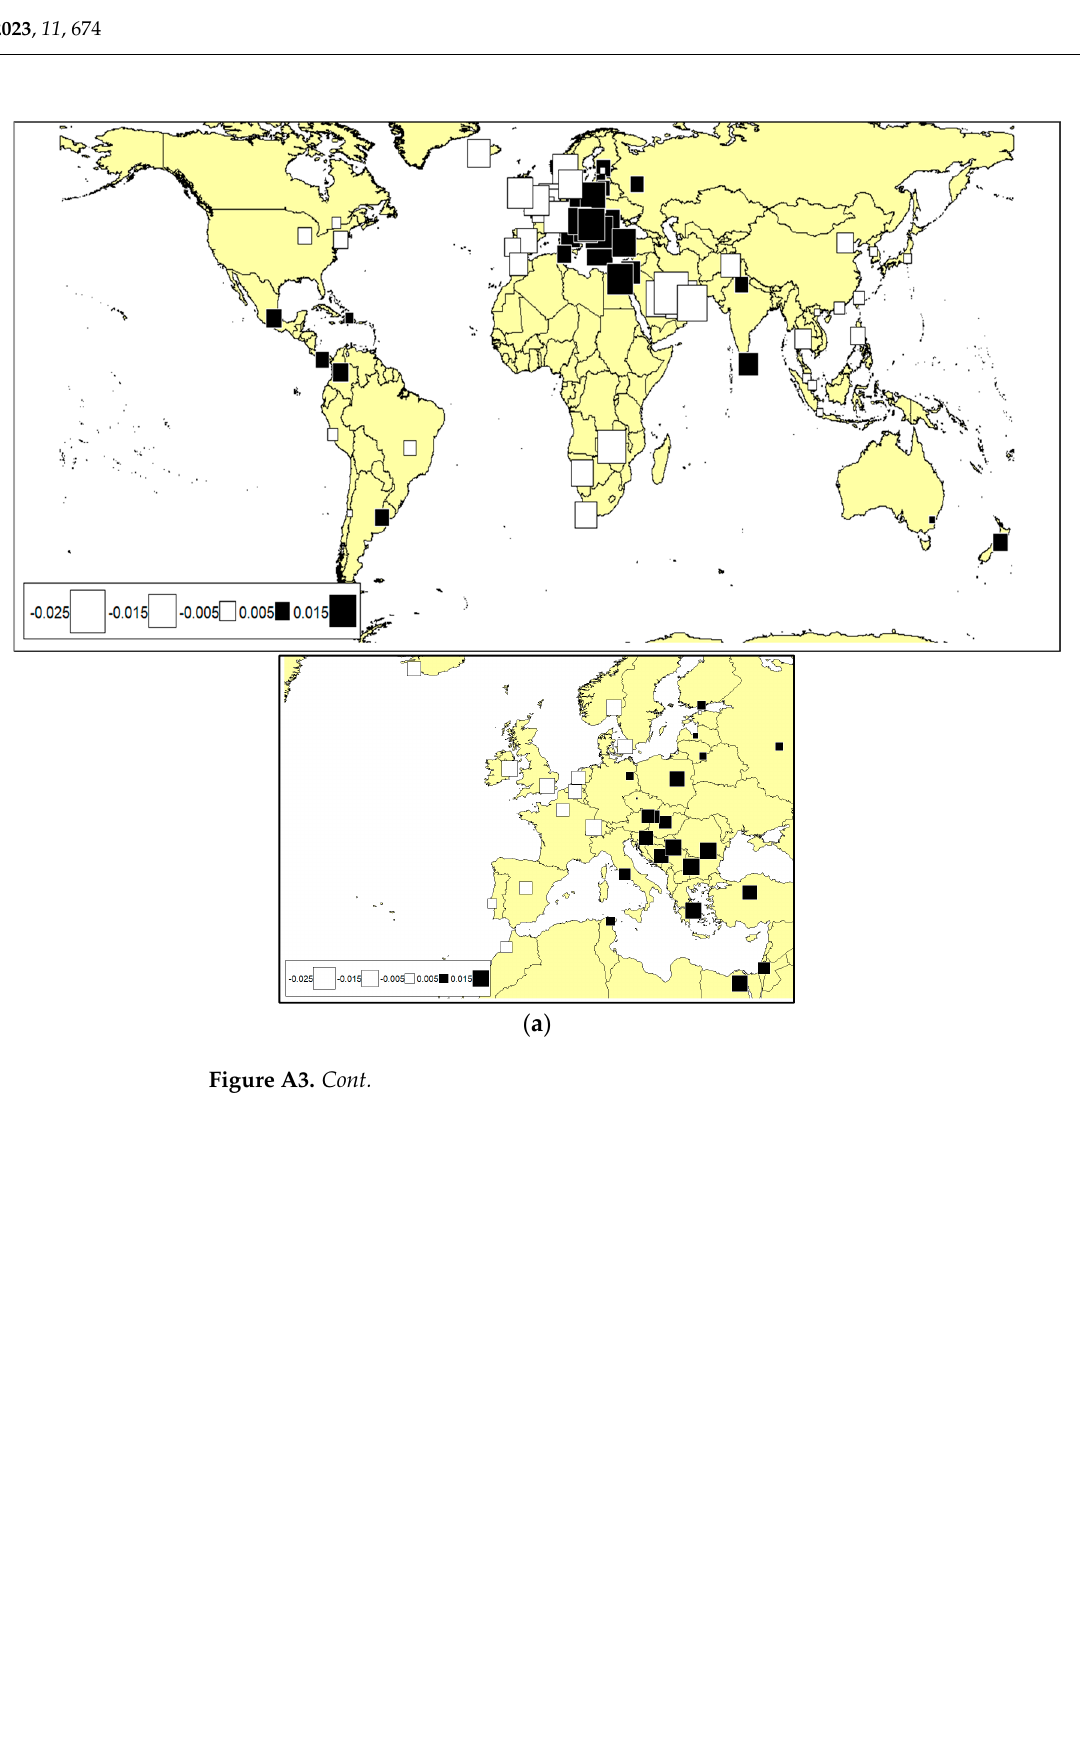
Figure A2. Map of projected first PC scores from FPCA: ( a ) period 1; ( b ) period 2; ( c ) period 3.